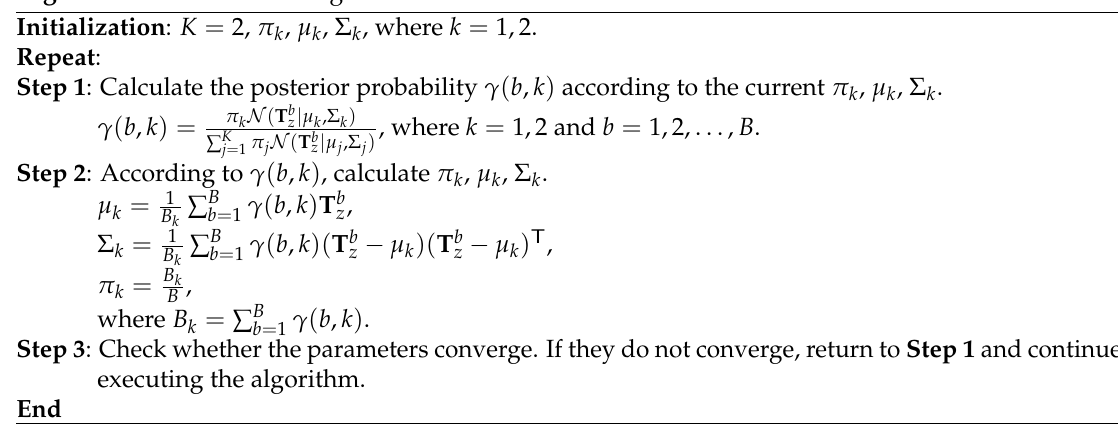
Algorithm 1 : Offline training based on